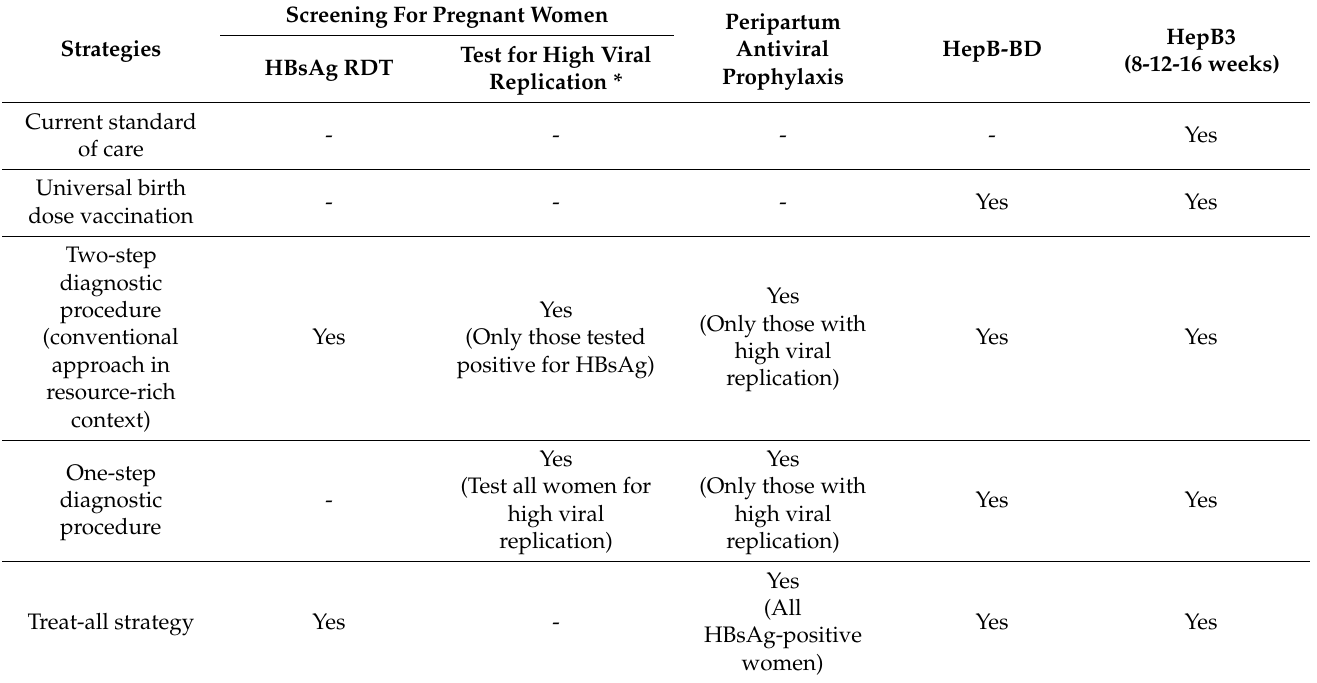
Table 1. Strategies for the prevention of mother-to-child transmission of